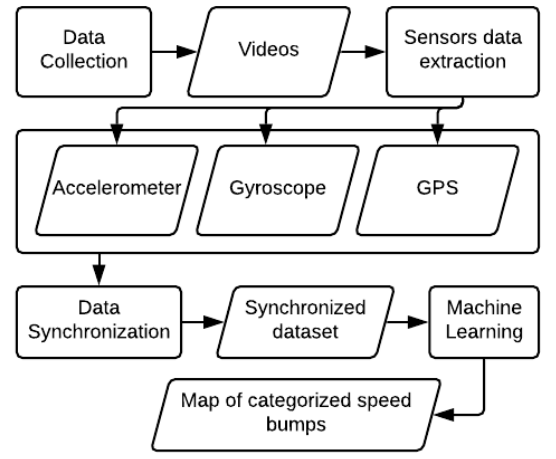
Figure 1. Flowchart of proposed methodology.